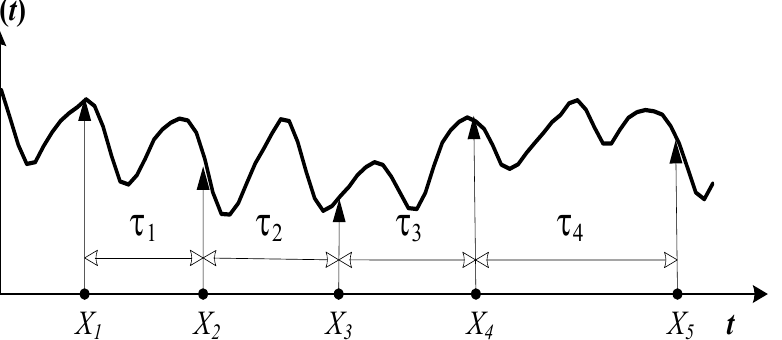
Figure 4. A schematic diagram illustrating non-uniform embedding of a scalar time series into a 5-dimensional delay-coordinate space. X 1 , . . . , X 5 denote the axes of the reconstructed phase space; τ 1 , . . . , τ 4 denote time